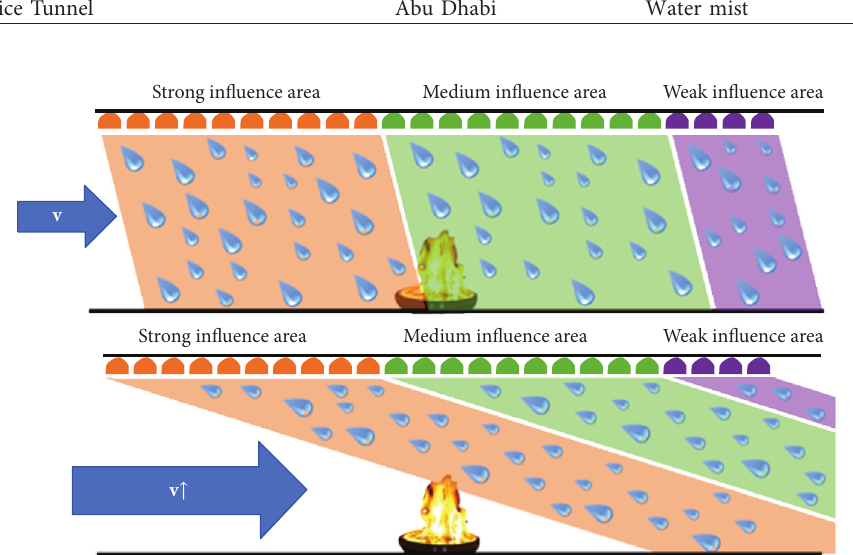
Figure 1: Water mist droplets have long downstream distance at higher longitudinal ventilation.